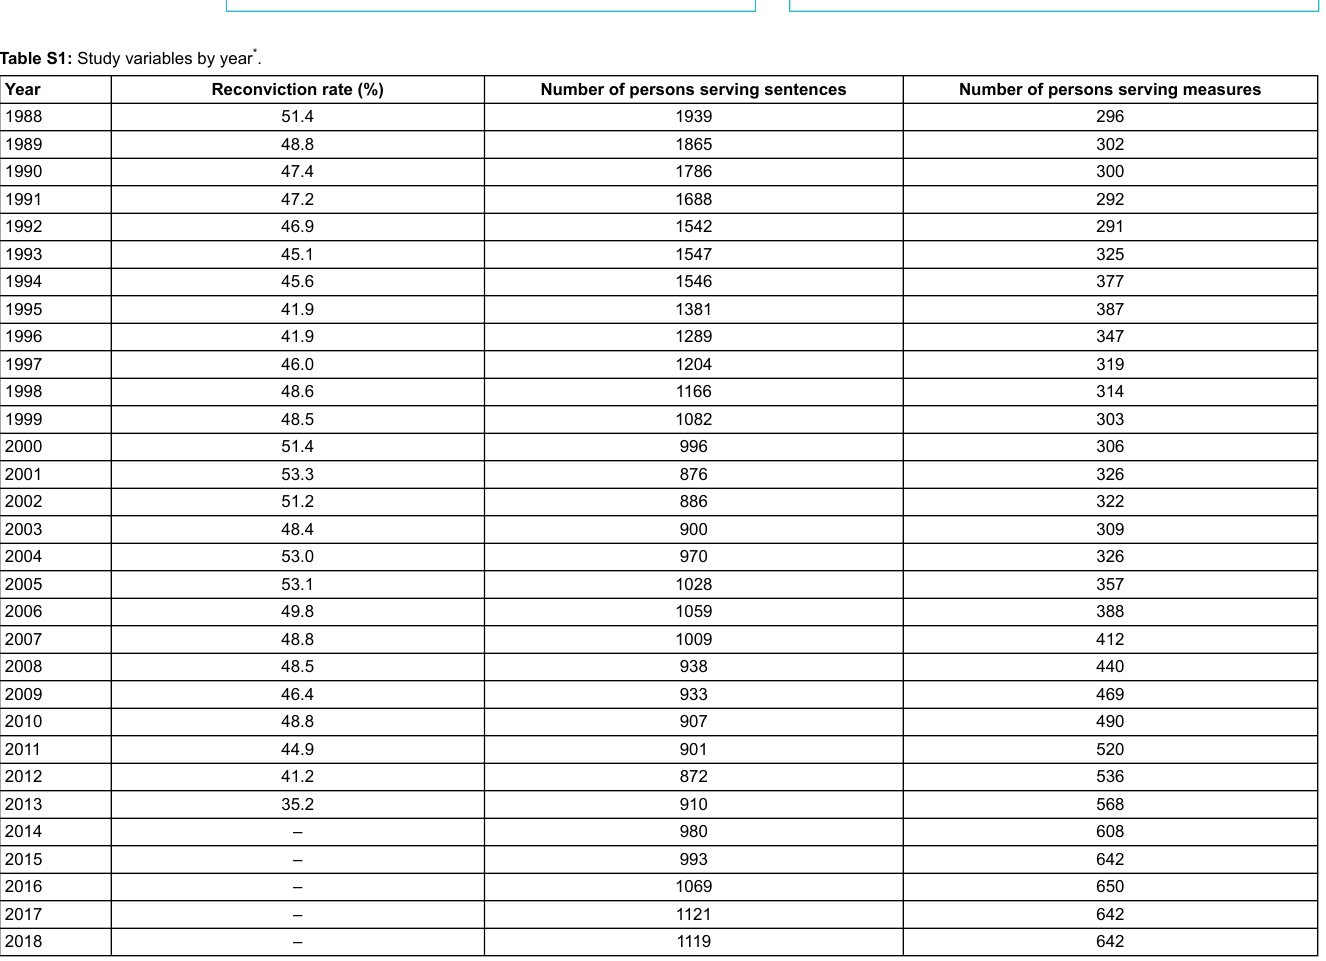
Table S1: Study variables by year * . Year Reconviction rate (%) Number of persons serving